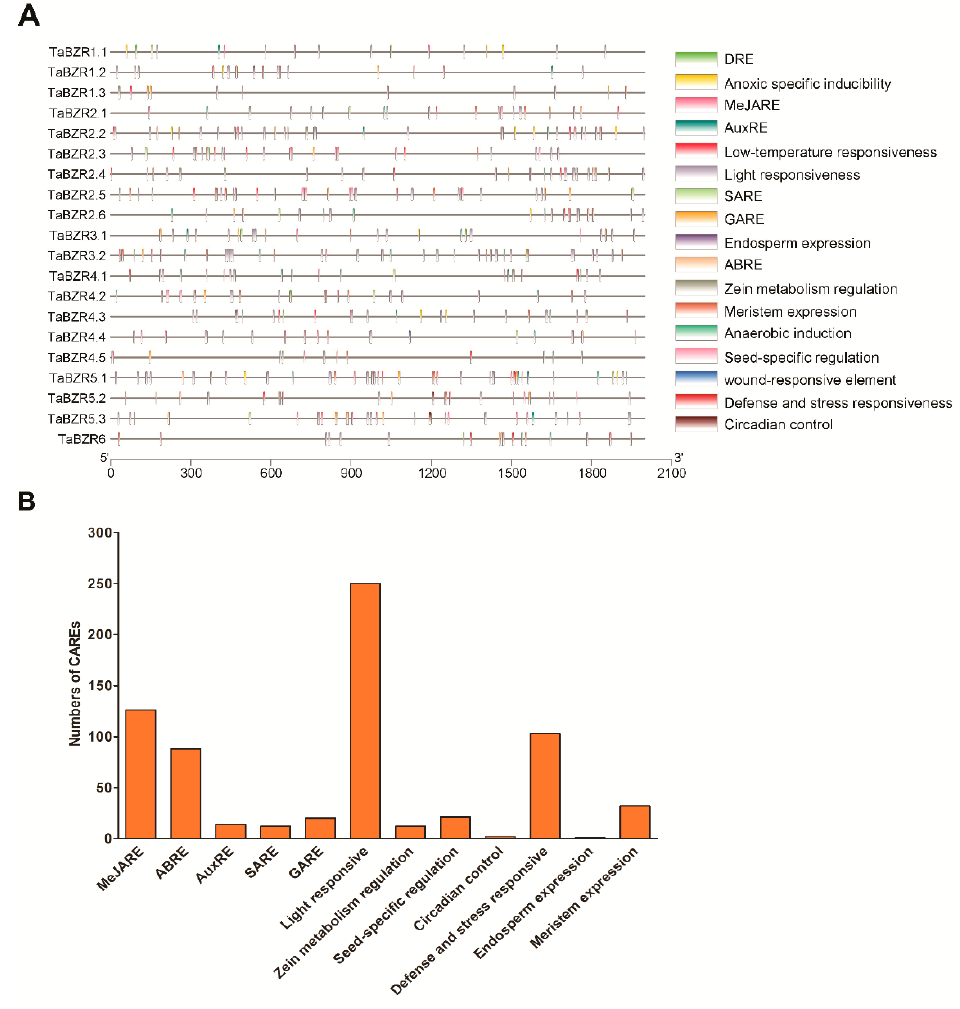
Figure 7. Cis-acting regulatory elements (CAREs) of the TaBZR gene family. The CAREs analysis was performed with a 2 kb upstream region using PlantCARE online server. ( A ) Hormone-responsive elements, stress-responsive elements, growth, and development-related elements, light-responsive elements, and other elements with unknown functions are shown by different colors. ( B ) Most commonly occurring CAREs in TaBZRs.